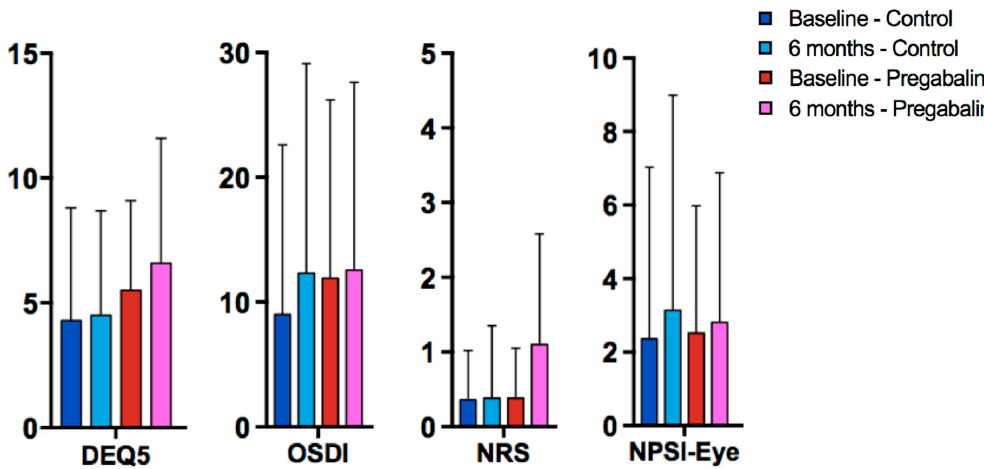
Figure 2. Comparison of Ocular Symptom Scores at Baseline and 6-Months. DEQ5 = Dry Eye Questionnaire 5, OSDI = Ocular Surface Disease Index, NRS = Numerical Rating Scale for ocular pain averaged over one week recall, NPSI-Eye = Neuropathic Pain Symptom Inventory modified for an eye.